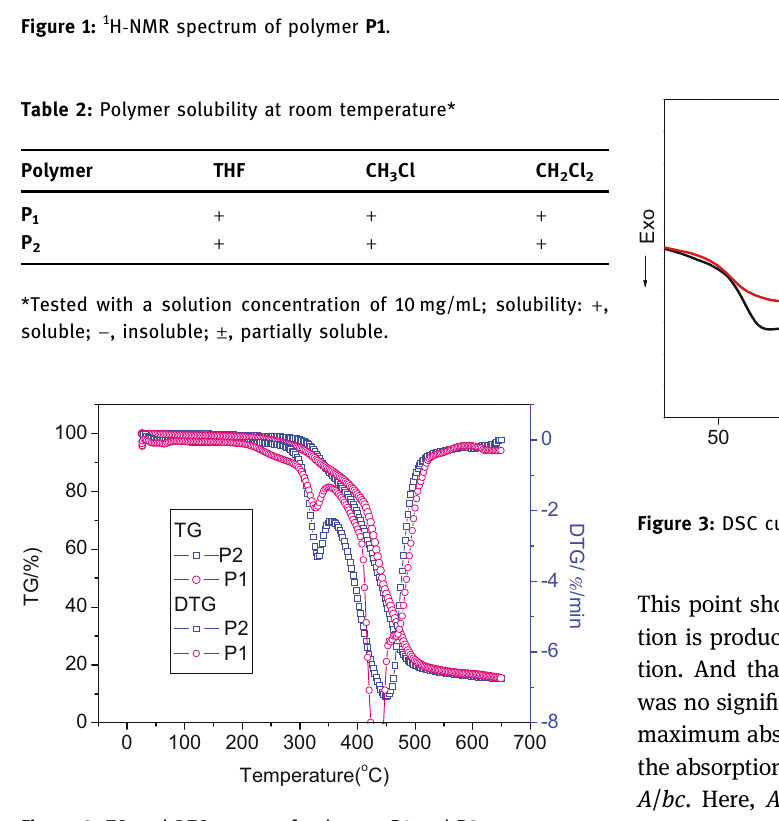
Figure 2: TG and DTG curves of polymers P1 and P2 .